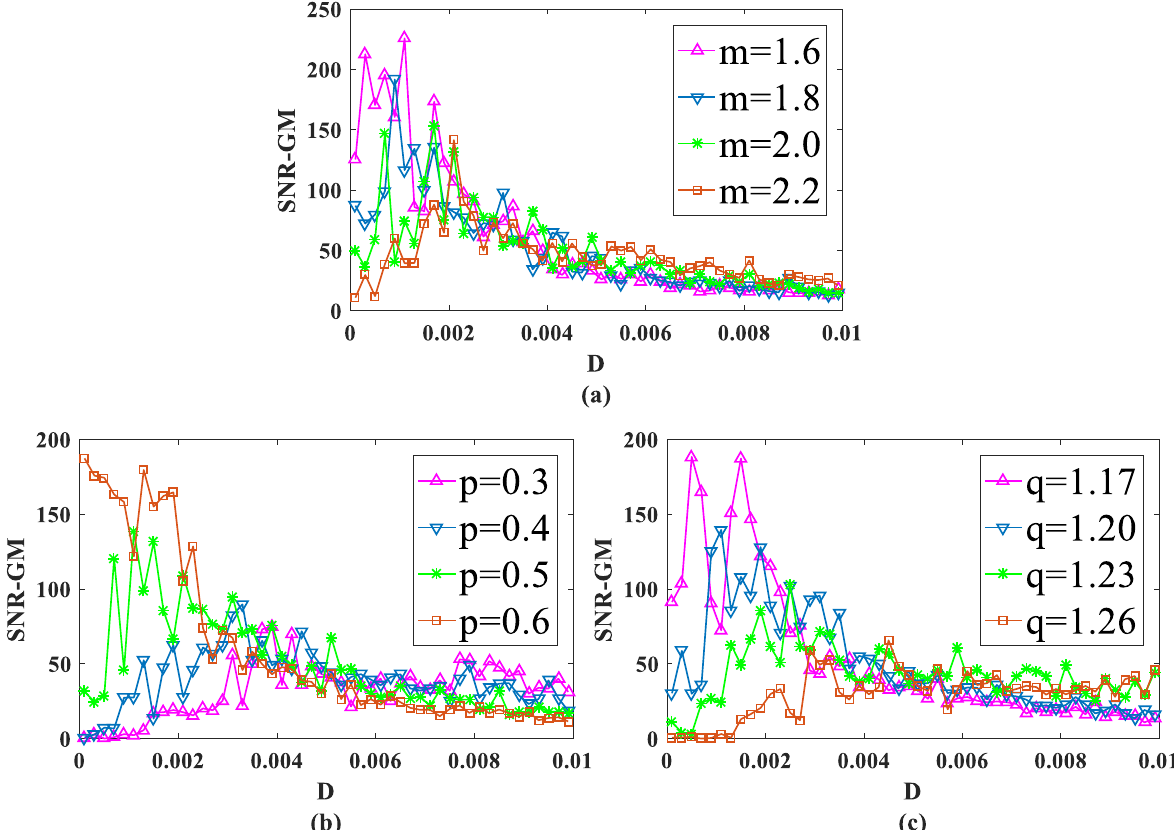
Figure 4. SNR-GM of system: ( a ) Just change m ( p = 0.5, q = 1.2), ( b ) Just change p ( m = 2.0, q = 1.2), ( c ) Just change q ( m = 2.0, p = 0.5).